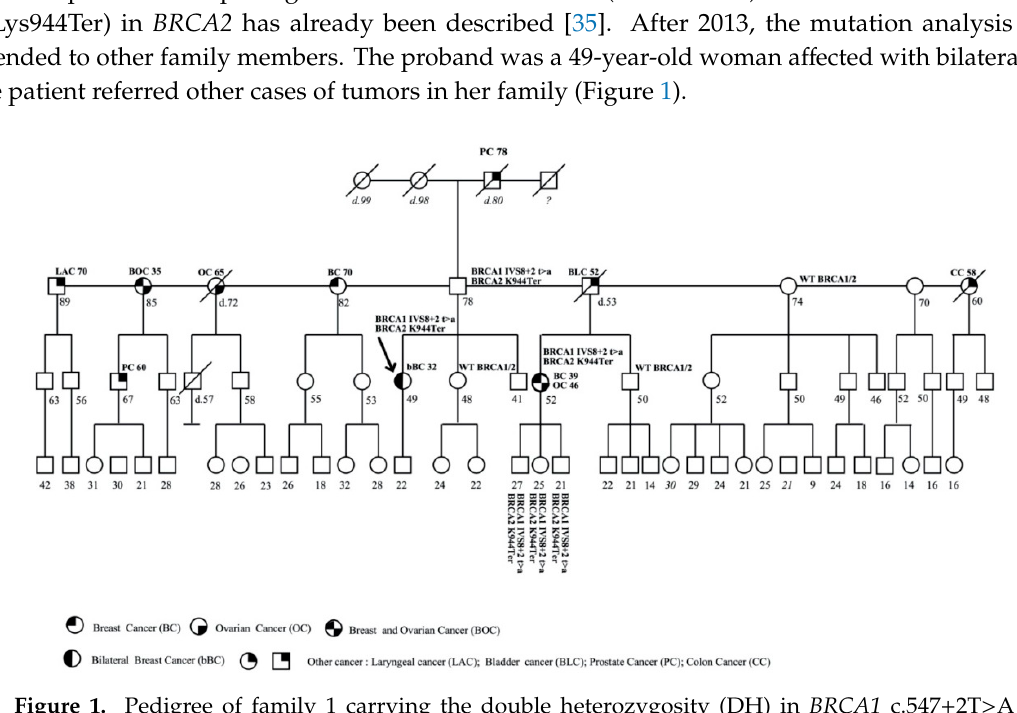
Figure 1. Pedigree of family 1 carrying the double heterozygosity (DH) in BRCA1 c.547+2T>A (IVS8 + 2T > A) and BRCA2 c.2830A > T (p.Lys944Ter). The ages at diagnosis are indicated in